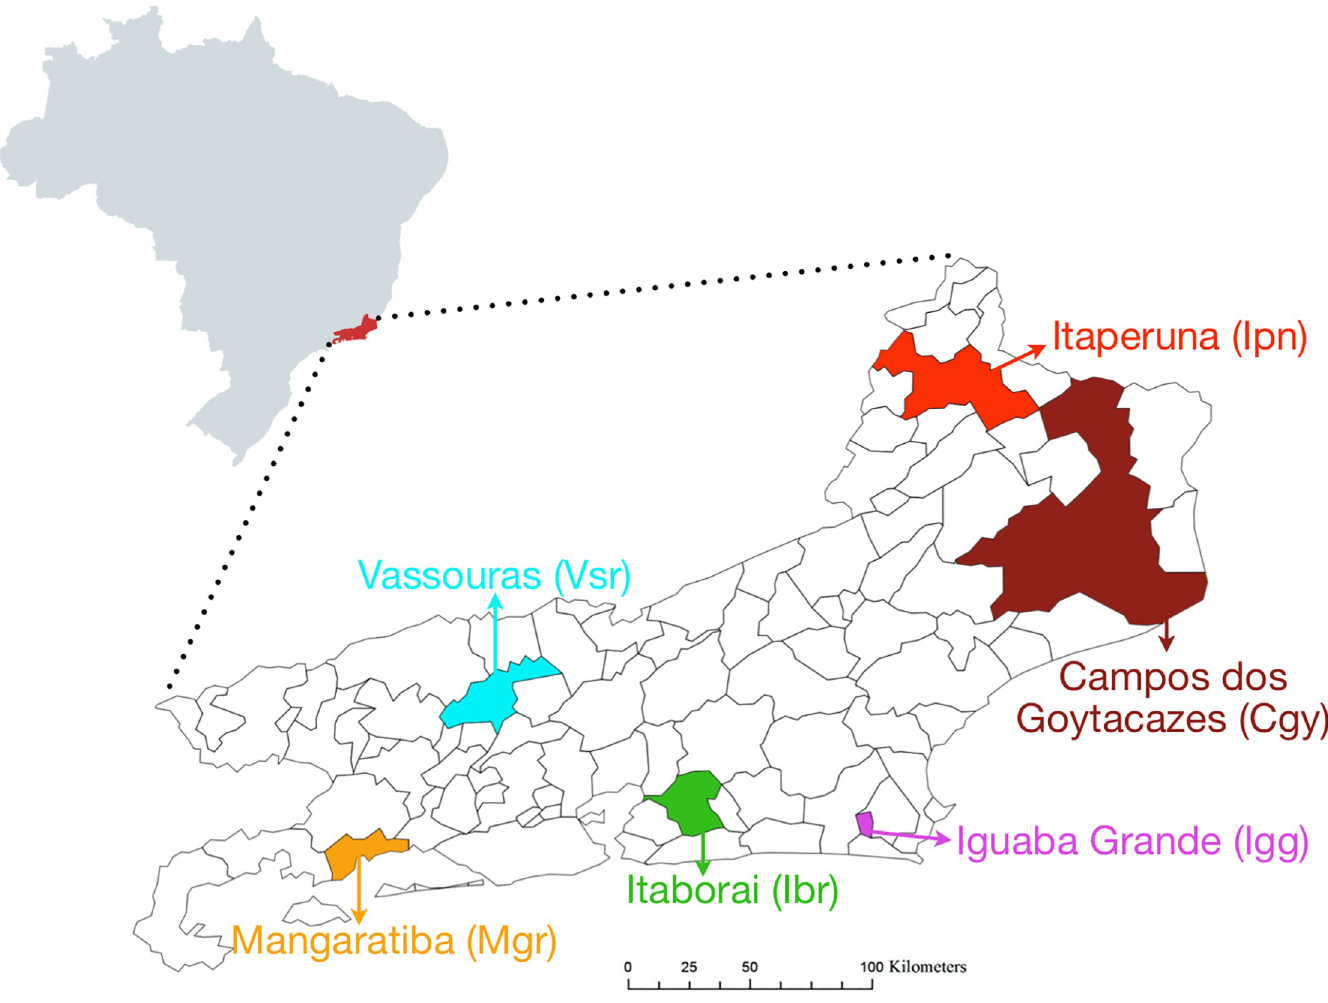
Fig 1. Map of Rio de Janeiro State with the six municipalities where we collected Aedes spp. for our study. (Maps were created with open-source scripts in R platform. The shapefiles used to insert the correct map boundaries were all retrieved from public domain sources: Geobr R package, available at https://cran.r-project. org/web/packages/geobr/vignettes/intro_to_geobr.html).